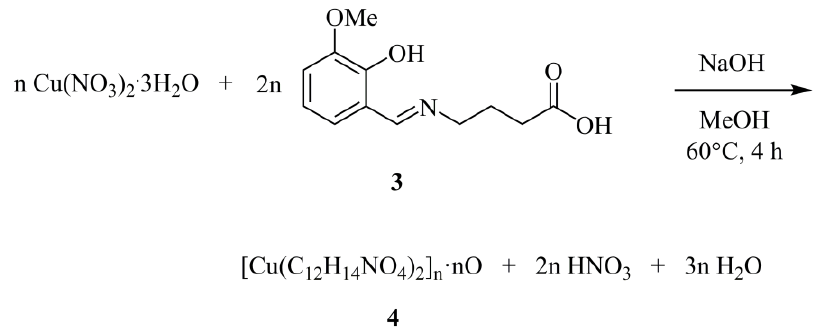
Entry Additive Yield (%)